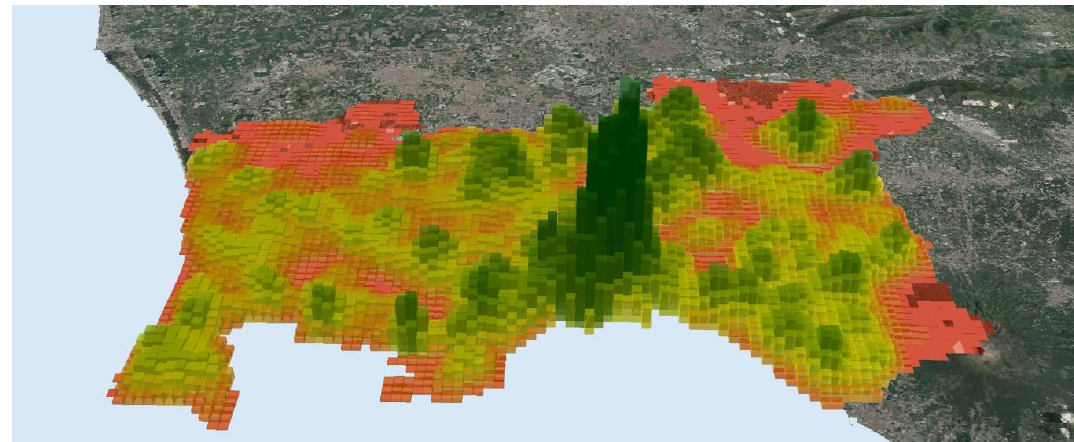
Figure 6. 3D visualisation of Regulation Services values with Jenks natural breaks categorisation. The colour gradient and histogram height show high (green) and low (red) UES values.